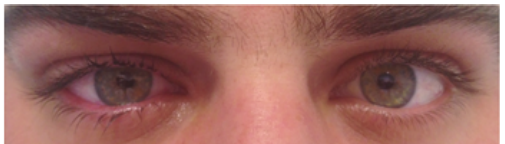
Figure 2: Patient’s photo with round and regular pupil of both eyes one day after CXL treatment of the right